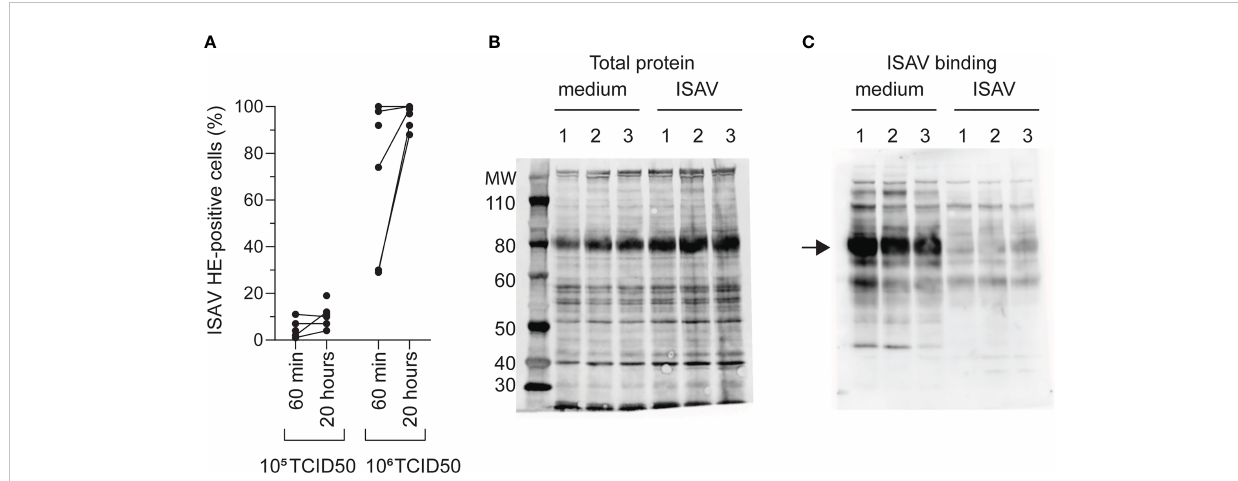
FIGURE 3 Loss of ISAV binding is not mediated by saturation of its cellular receptor. (A) Density-puri fi ed erythrocytes isolated from non-infected fi sh were incubated with ISAV at the indicated dose (per 20 million cells) and given duration, and the percentage of HE-positive cells was quanti fi ed by fl ow cytometry. Data points show measurements in cells from individual fi sh, with lines connecting values from the same fi sh when relevant. (B, C) Membrane-enriched erythrocyte lysates from three fi sh (1, 2, 3) exposed to medium or ISAV (10 5 TCID 50 per 20 million cells, 20 hours) were separated by SDS-PAGE and blotted to nitrocellulose membranes. (B) Blots were stained for total protein by Revert700 Total Protein Stain, (C) and the level of ISAV receptor was evaluated by serial incubation with ISAV antigen, mouse IgG 1 targeting HE (clone 3H6F8), HRP-conjugated secondary antibody, and substrate. The assay was repeated twice with identical results. The arrow points to the band representing ISAV binding in medium- treated